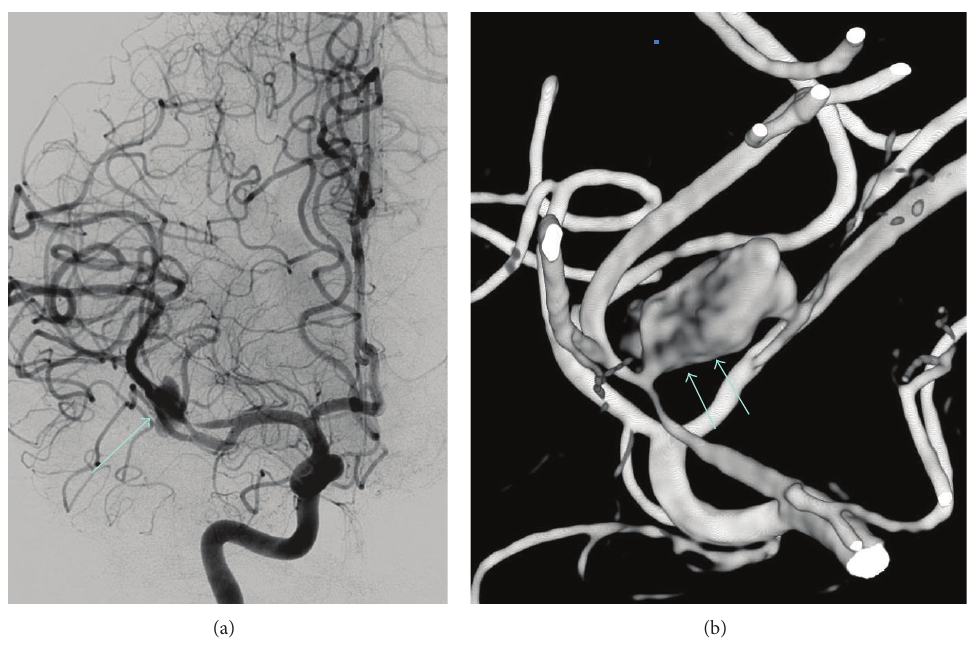
Figure 1: Septic aneurysm of the superior branch of the right middle cerebral artery bifurcation. Anteroposterior view of the right internal carotid angiogram showing the aneurysm (arrow) and visualization of the aneurysm on three-dimensional reconstruction (double